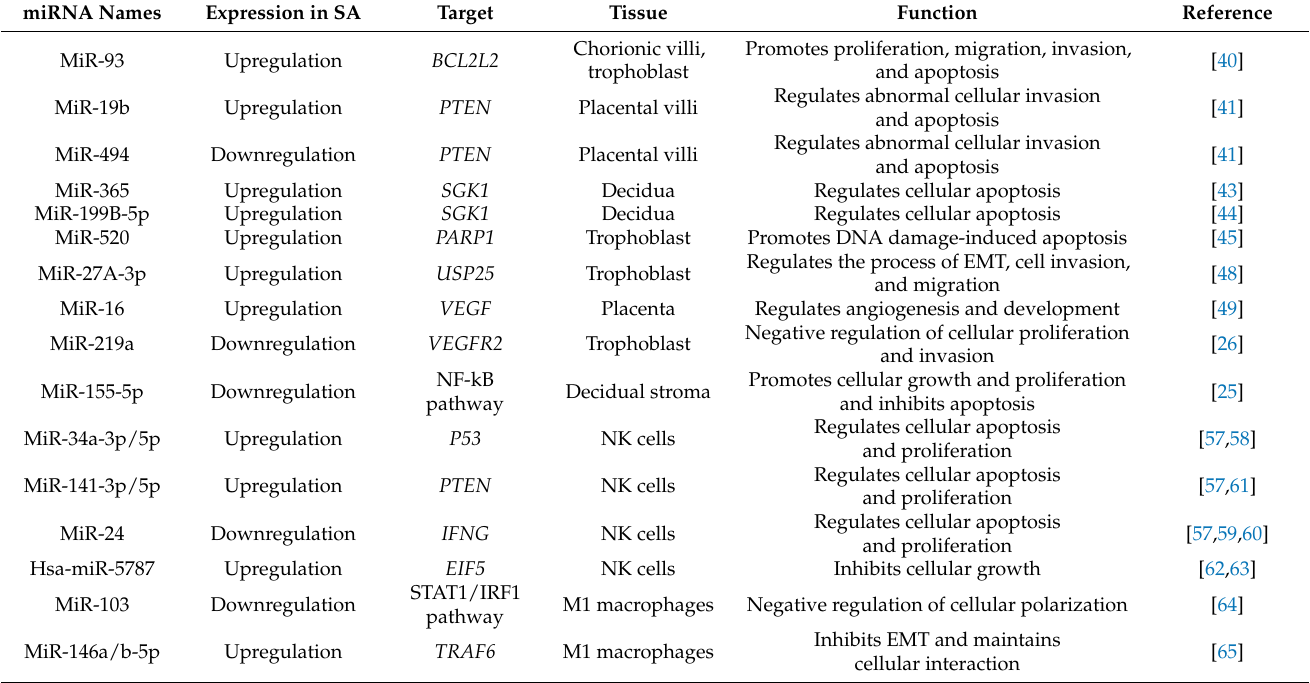
Table 1. miRNAs involved in regulating SA genesis and